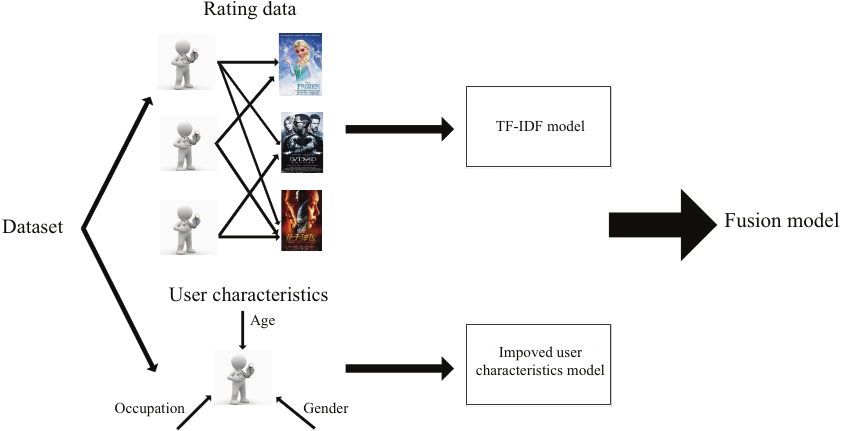
Figure 3. Framework of the proposed collaborative filtering